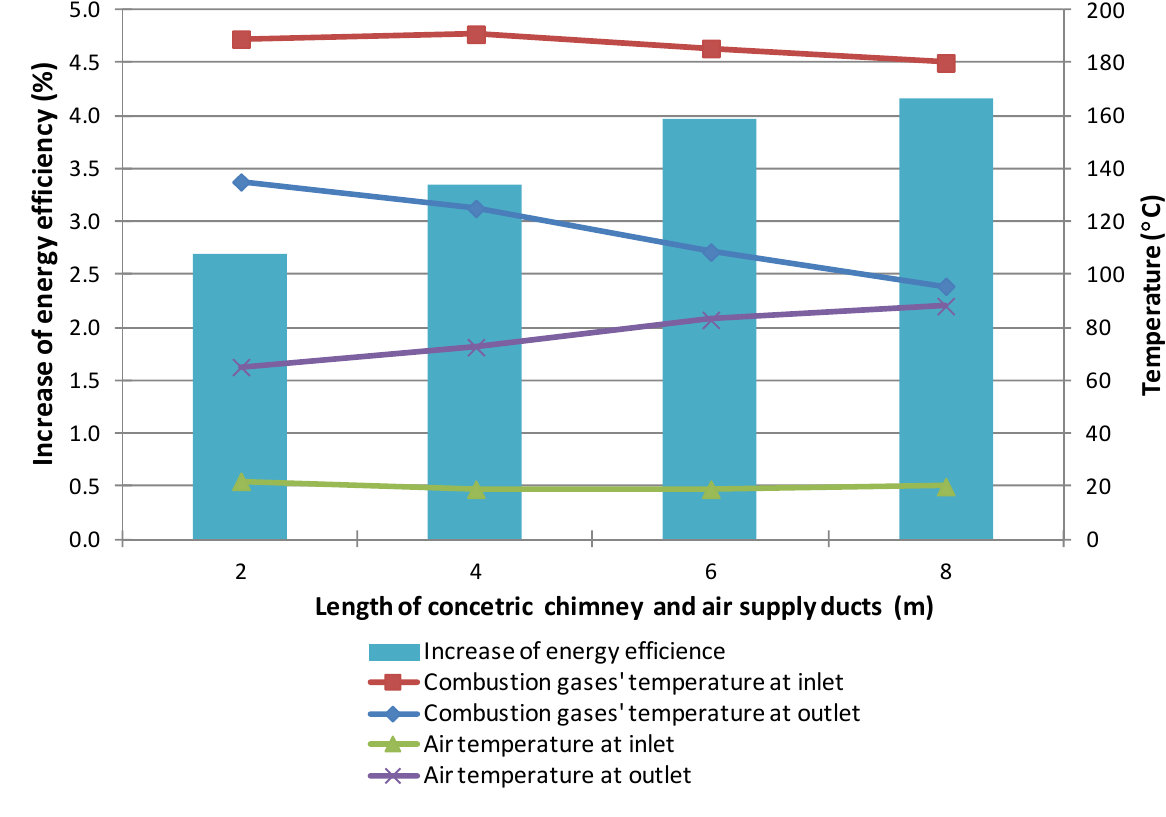
Figure 2. Increase in energy efficiency of gas appliance, as well as temperature of air and combustion gases at the inlet and at the outlet of a single concentric chimney and air supply duct